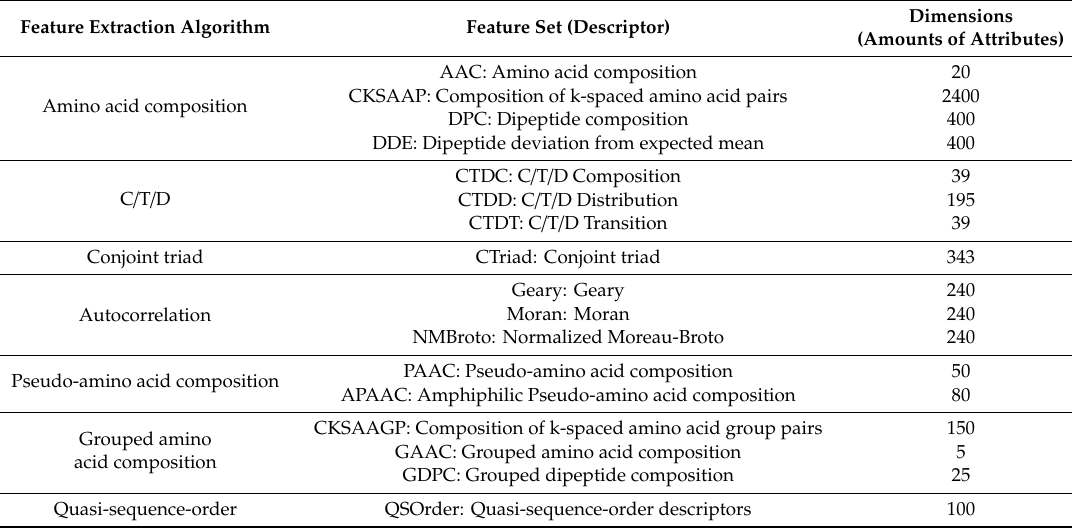
Table 1. Properties of feature sets (descriptors) were used in this research. Feature Extraction